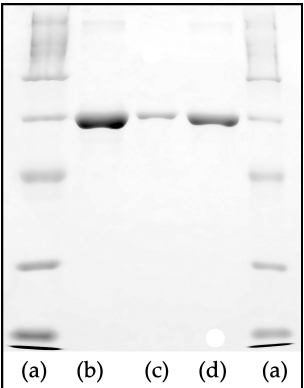
Figure 7. Sodium dodecyl sulphate electrophoresis (SDS-PAGE) results of adsorbed bovine serum albumin (BSA) onto the scaffolds. ( a ) marker; ( b ) PCL; ( c ) PCL-PPyHA; ( d ) PCL-PPyHA-CD.